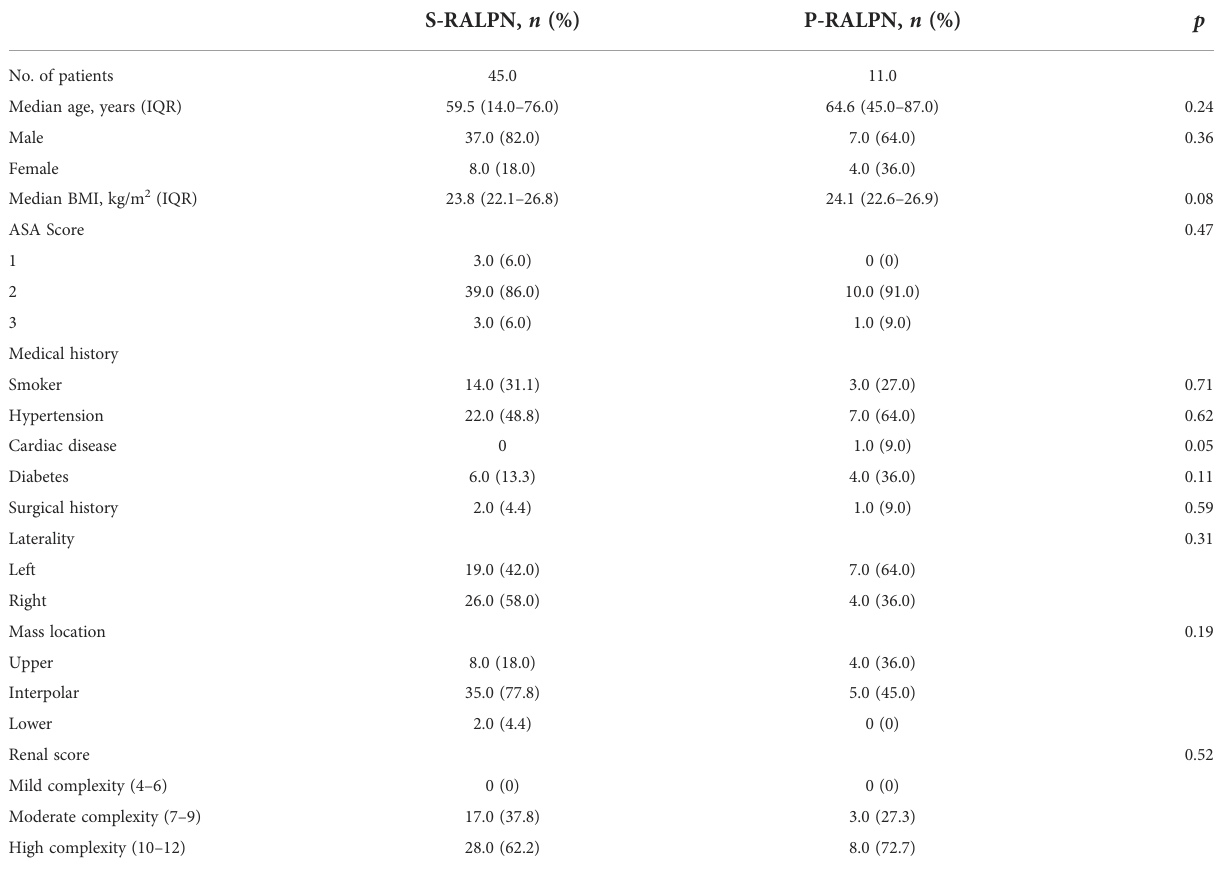
TABLE 1 Patient